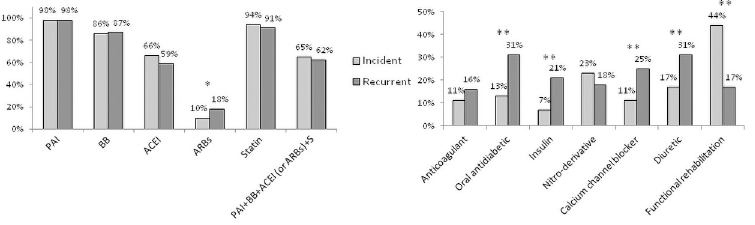
Fig 2. Drug treatments upon hospital discharge in patients with an incident or recurrent acute coronary syndrome. � p < 0.05, �� p < 0.0001, after adjustment for sex and age. PAI: Platelet aggregation inhibitor; BB: Beta- blocker; ACEI: Angiotensin-converting-enzyme inhibitor; ARBs: Angiotensin receptor blockers; S: Statin.